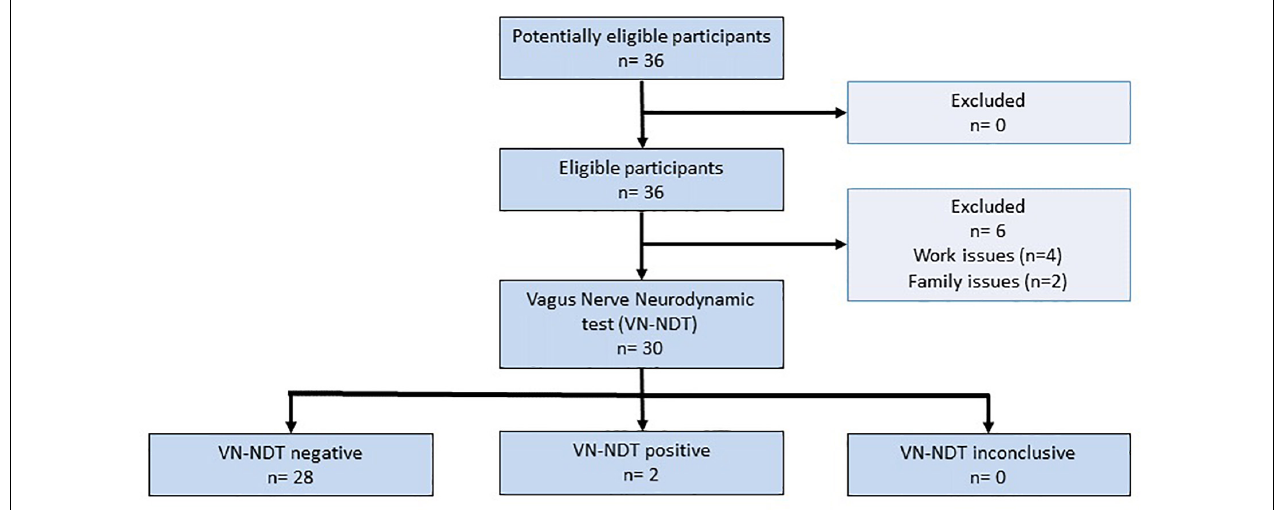
FIGURE 2 | STARD flowchart of the vagus nerve neurodynamic test